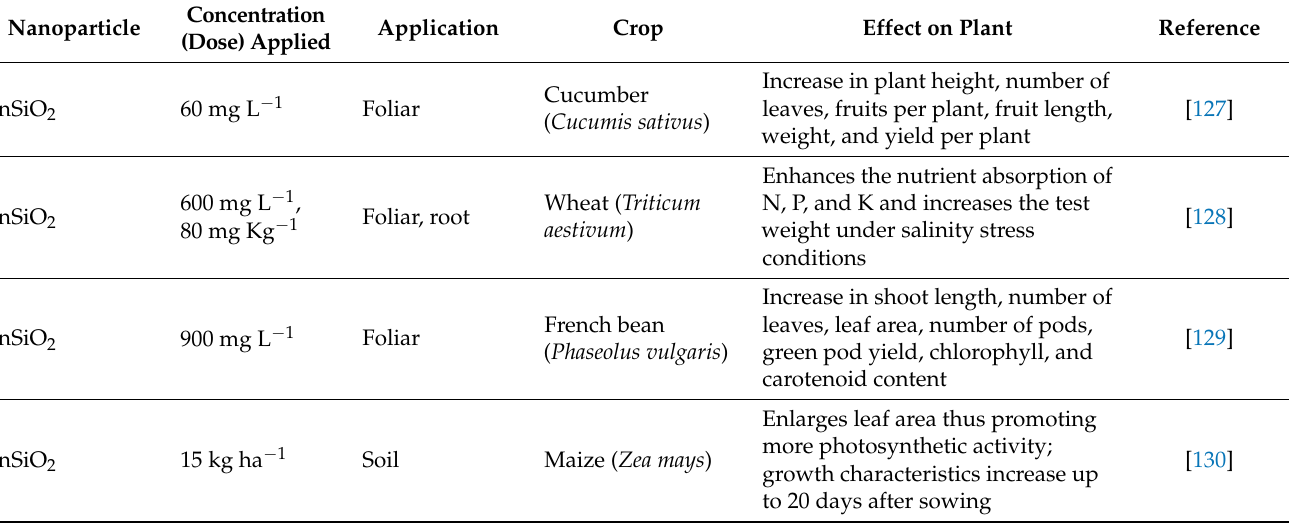
Table 3. Nano silica (Silicon dioxide nanoparticles), nSiO 2 application for growth and yield attributes in different